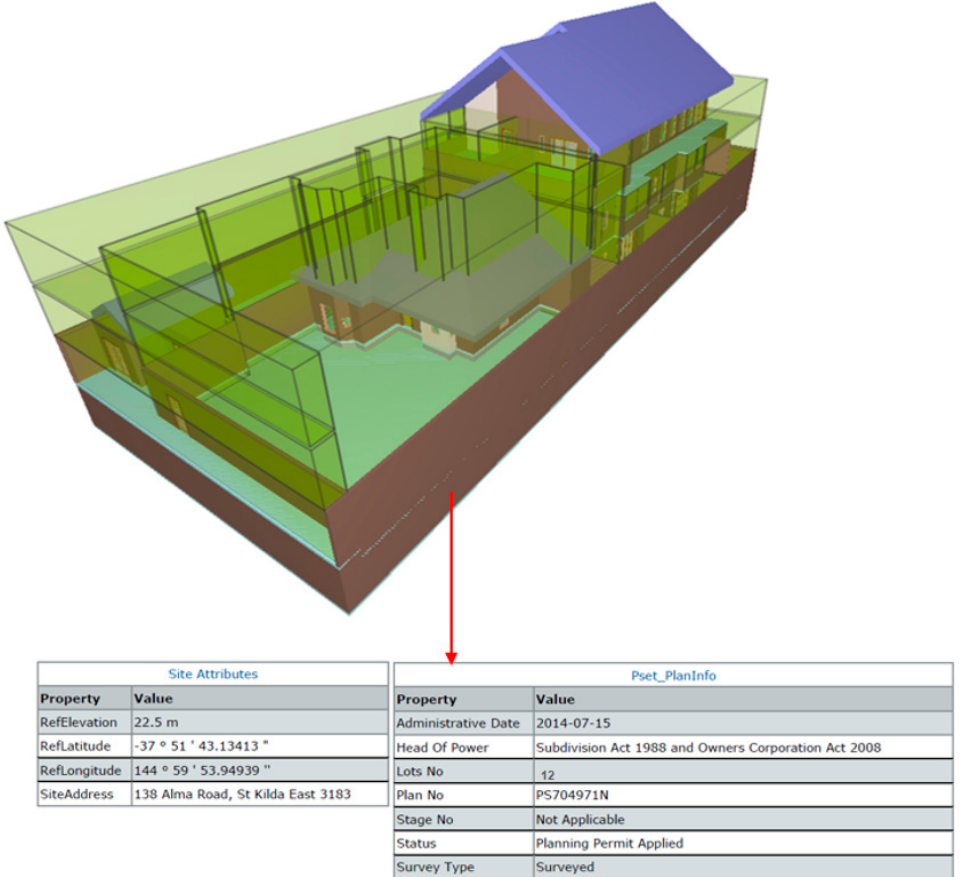
Figure 12. Integrated BIM model comprising legal and physical objects, as well as administrative information for the case study building.